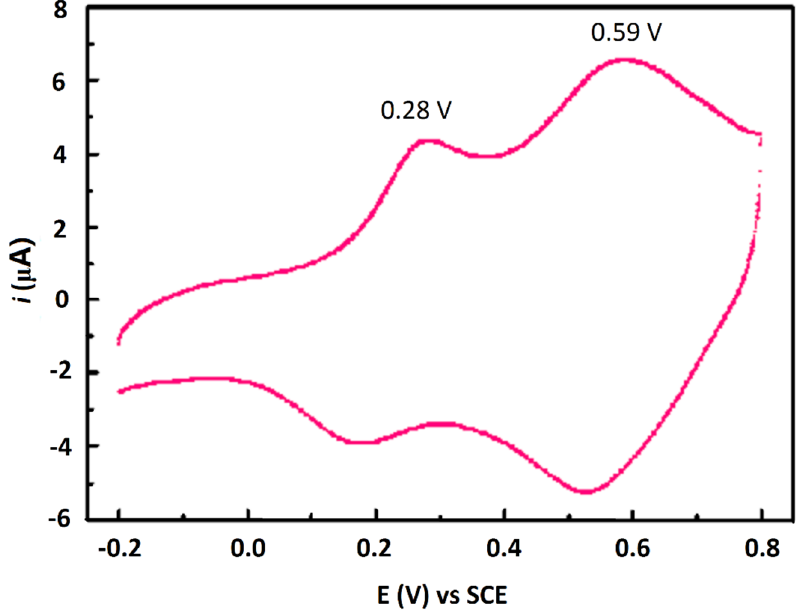
Figure 6. Cyclic voltammogram of AT in 1 M HCl solution (aniline tetramer modified glass carbon electrode used as work electrode) .